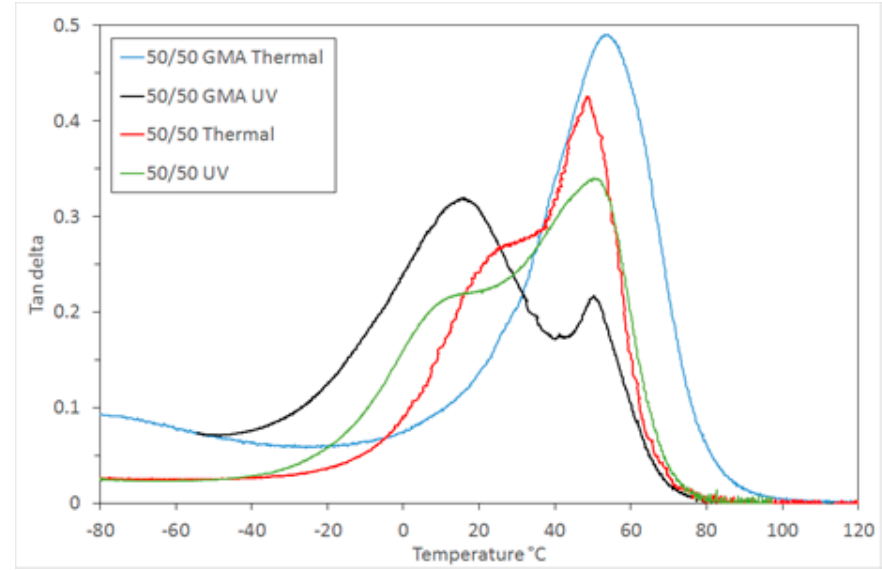
Figure 7. DMTA tan δ for 50/50 compositions initiated either thermally or by UV initiator, and with/without compatibiliser.